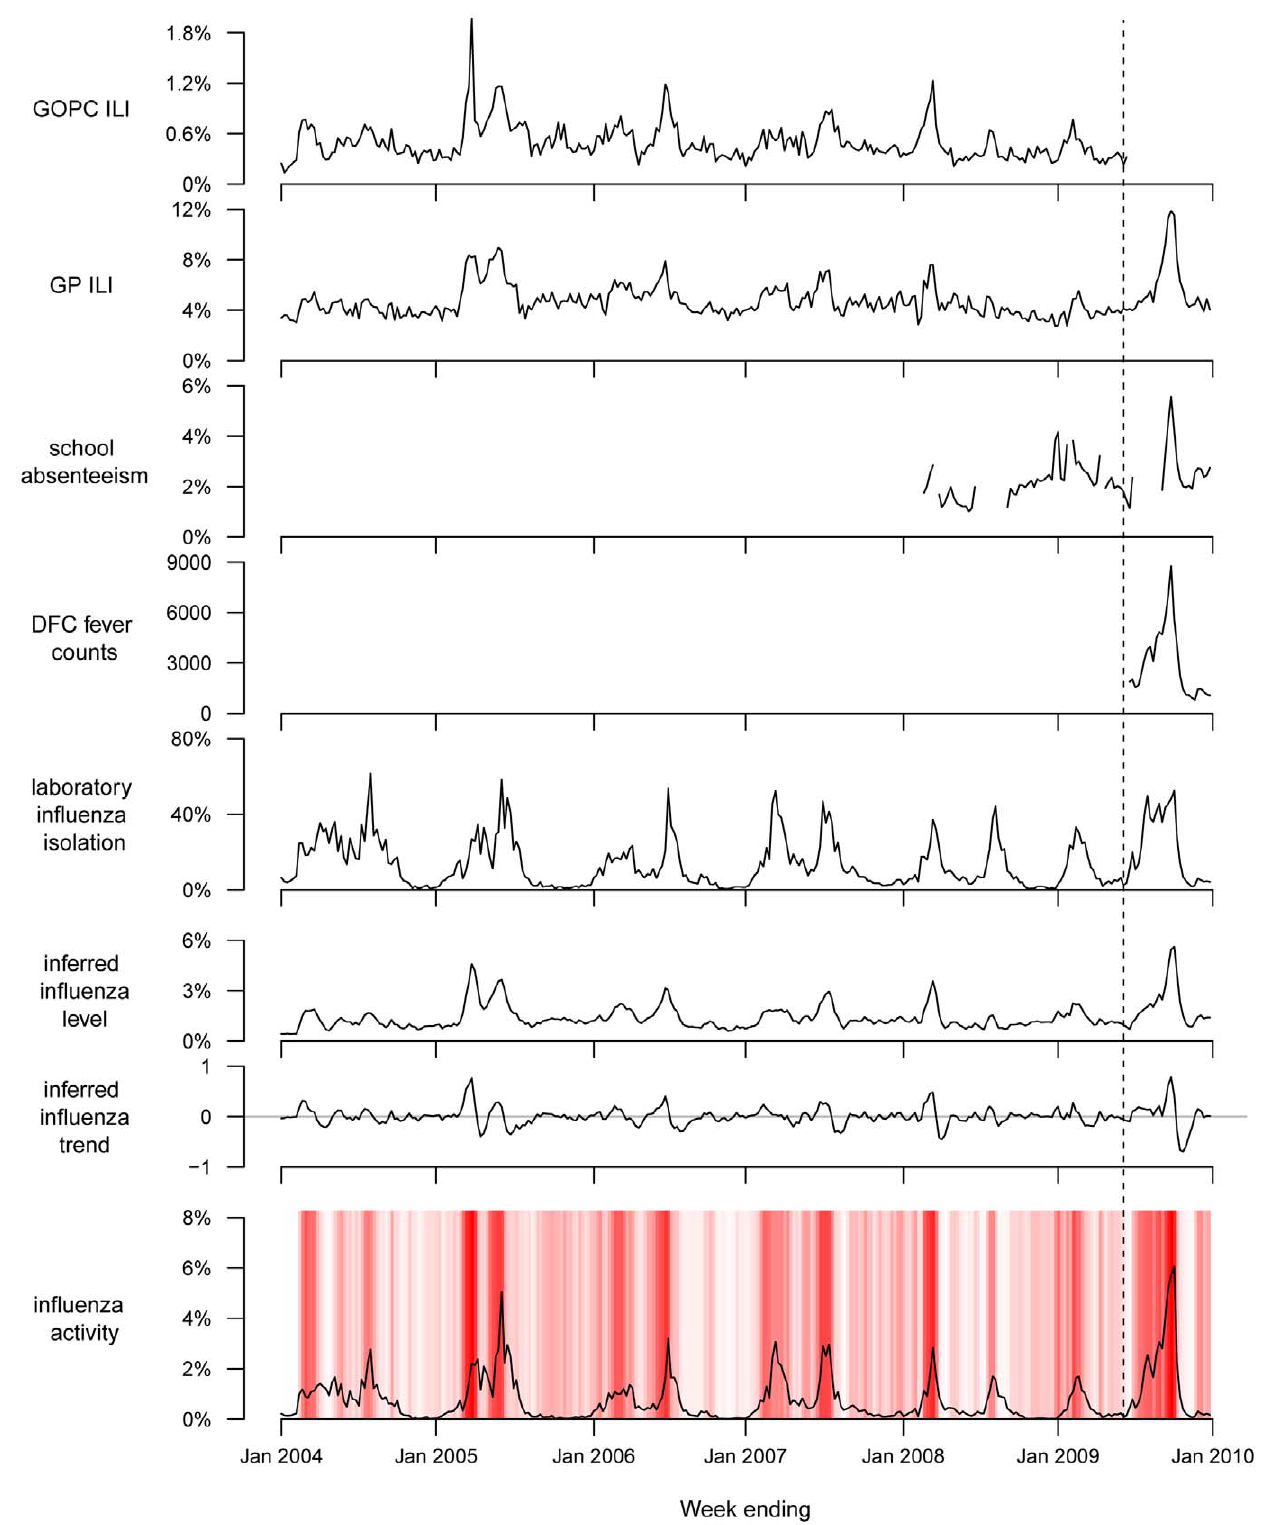
Figure 1. Surveillance data on influenza-like illness consultation rates in public General Outpatient Clinics (GOPC) and private general practitioners (GP), school absenteeism rates, and number of consultations with patients with febrile illness in Designated Flu Clinics which operatedduring thepandemicperiod;theinferredinfluenzalevelunderthedynamic linearmodelbasedonthesurveillancedatastreams andscaledtotherangeoftheinfluenzaactivityproxymeasure(productoflaboratoryinfluenzaisolationrateandGPILIrate);theinferred trend of influenza activity under the same model, scaled to the range [ 2 1, 1]; the laboratory influenza detection rates from January 2004 through December 2009. The inferred influenza activity index was superimposed and color-coded from white (low) to red (high) in each panel. The vertical dashed line indicates the start of the pandemic period.